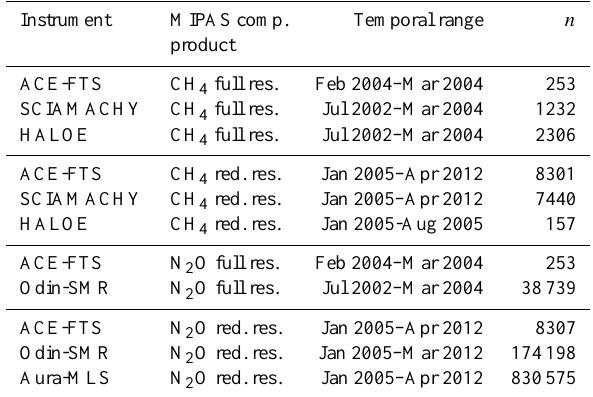
Table 1. Number of collocations n between the instruments and MI- PAS and their temporal ranges. Instrument MIPAS